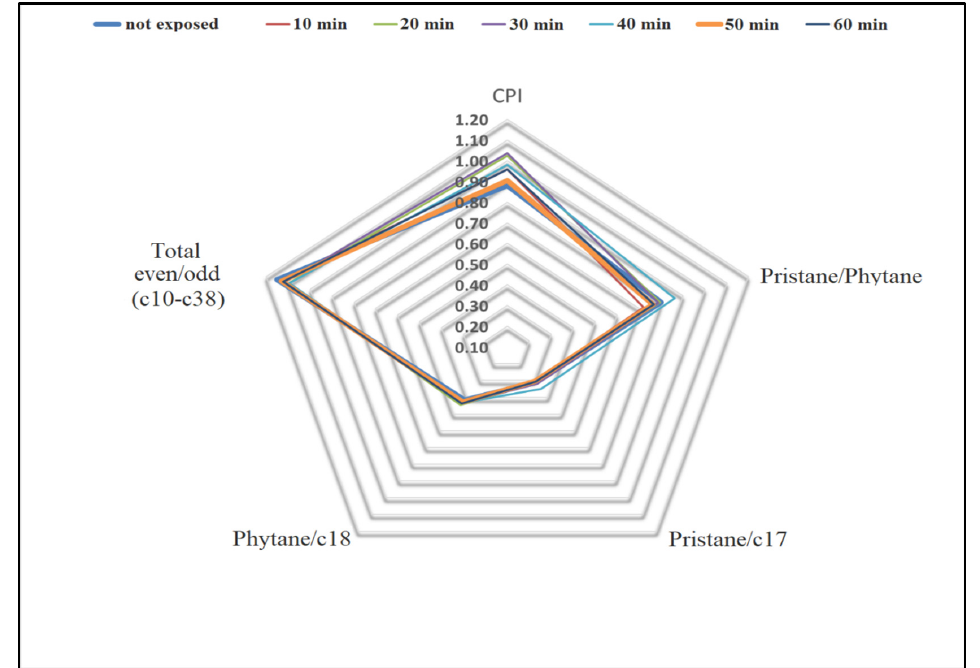
Figure 5. Changes in the geochemical characteristics of samples after an electromagnetic exposure.